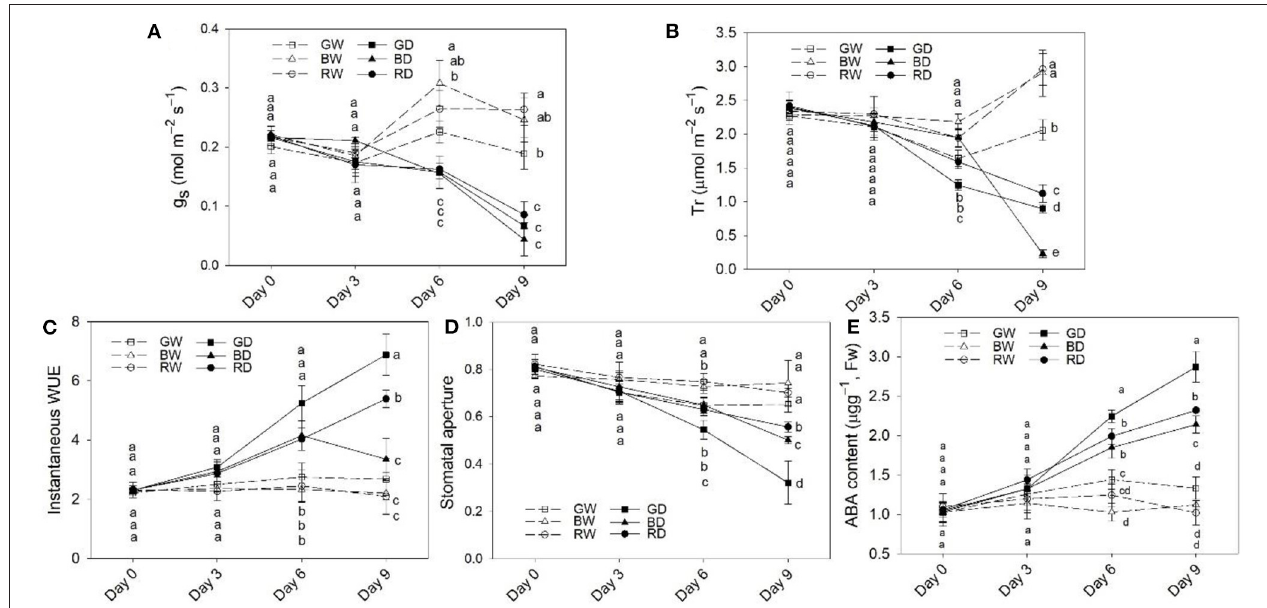
FIGURE 2 | The stomatal response, water use efficiency (WUE), and abscisic acid (ABA) content in leaves of plants under different water and light spectra condition. (A,B) , The responses of stomatal conductance (g s ) and transpiration rate (Tr) of plant leaves; (C) , The instantaneous WUE; (D) , stomatal aperture; (E) , ABA content in plant leaves after 9 days of treatment. RW, BW, and GW: well-water combined with red, blue, and green LED light, respectively; RD, BD, and GD: drought stress combined with red, blue, and green LED light, respectively. The PPFD for all the treatments was 200 µ mol m − 2 s − 1